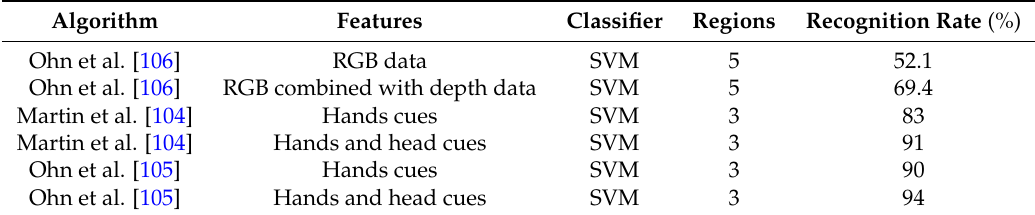
Table 4. Hands recognition in different regions inside the car using CVRR-HANDS 3D dataset